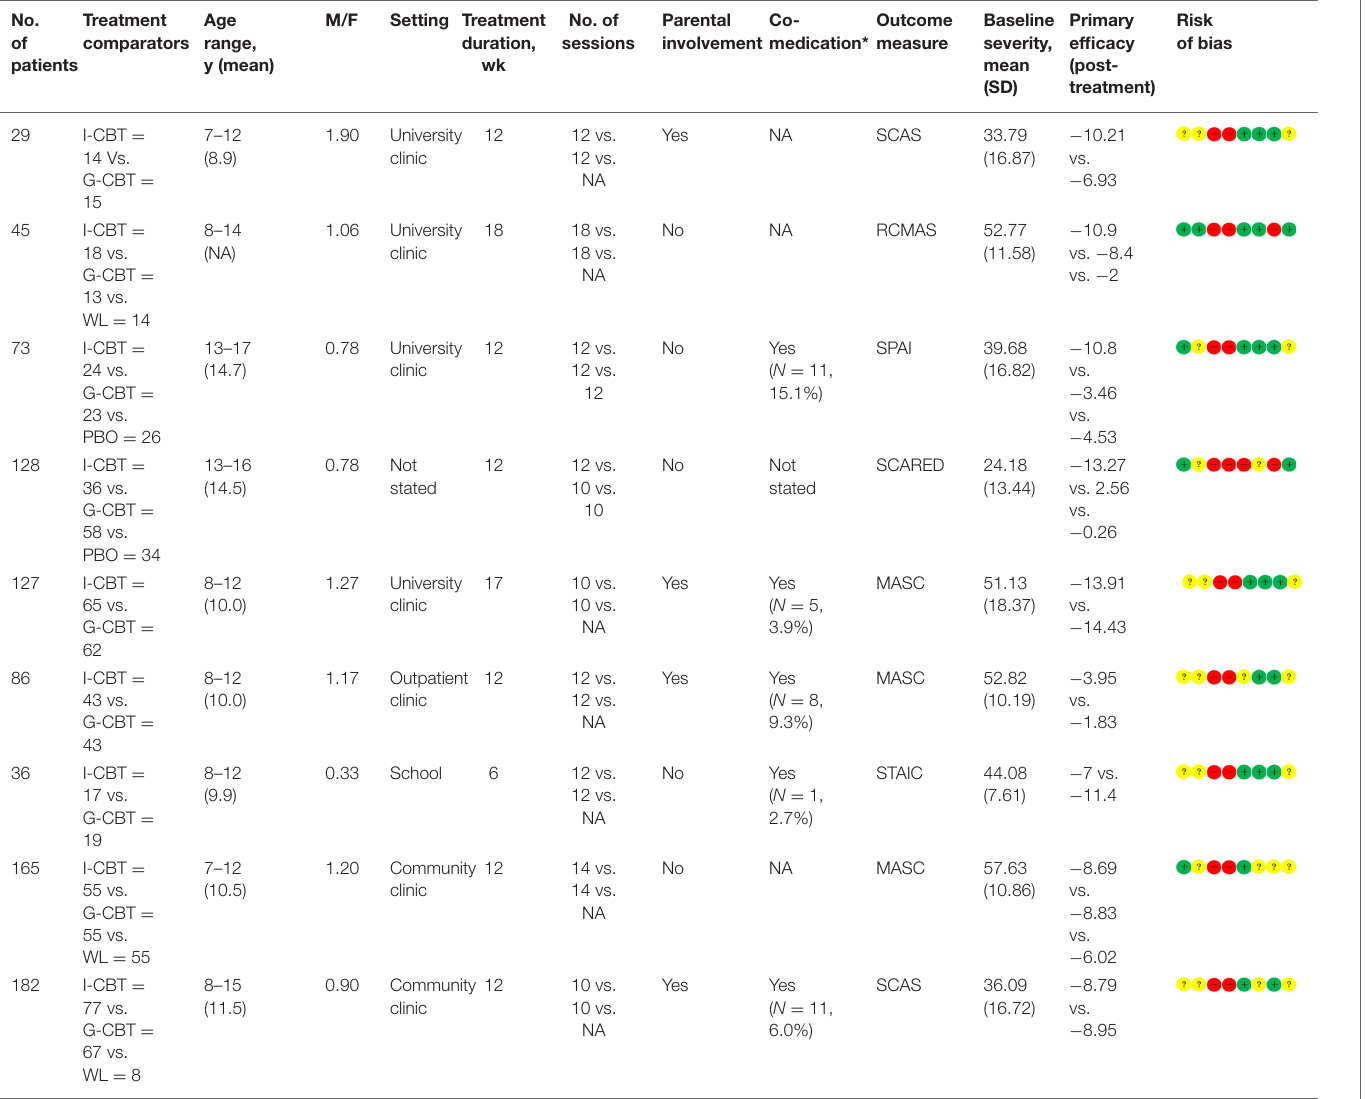
TABLE 1 | Characteristics of included studies.